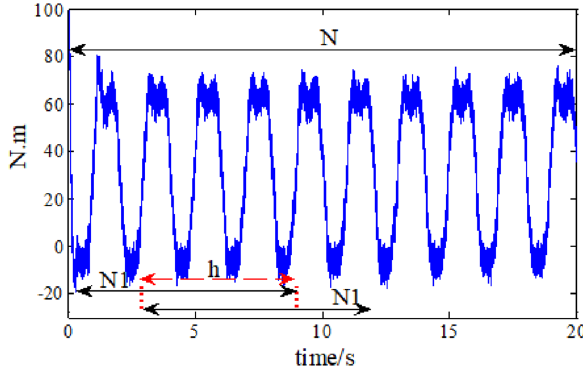
Figure 3. Schematic diagram of data set enhancement